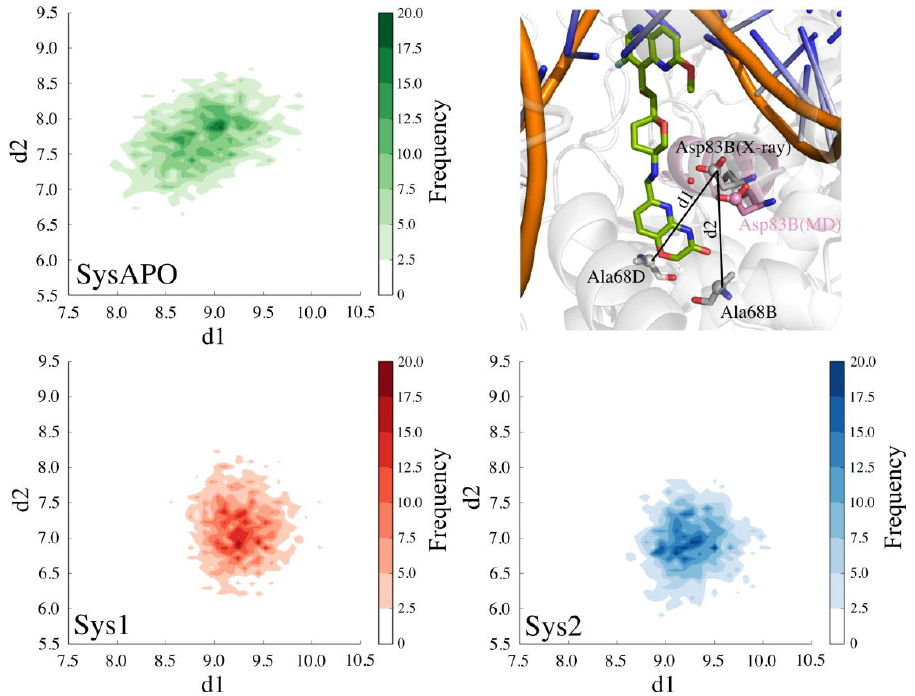
Figure 4. 2D plot of SysAPO ( green ), Sys1 ( red ), and Sys2 ( blue ) MD trajectory data plotted along d1 (distance between the Cγ of Asp83B and the Cα of Ala68D) and d2 (distance between the Cγ of Asp83B and the Cα of Ala68B).